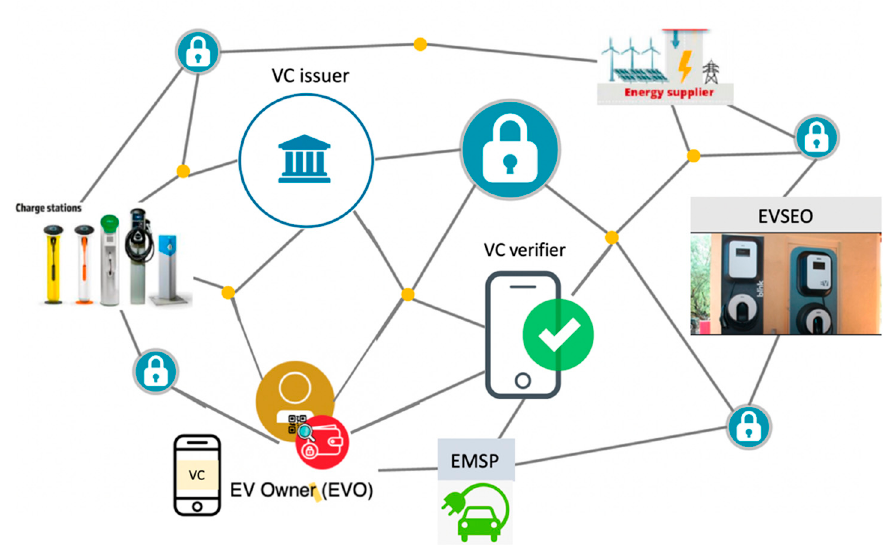
Figure 1. Electric Vehicle ( EV) roaming system context.